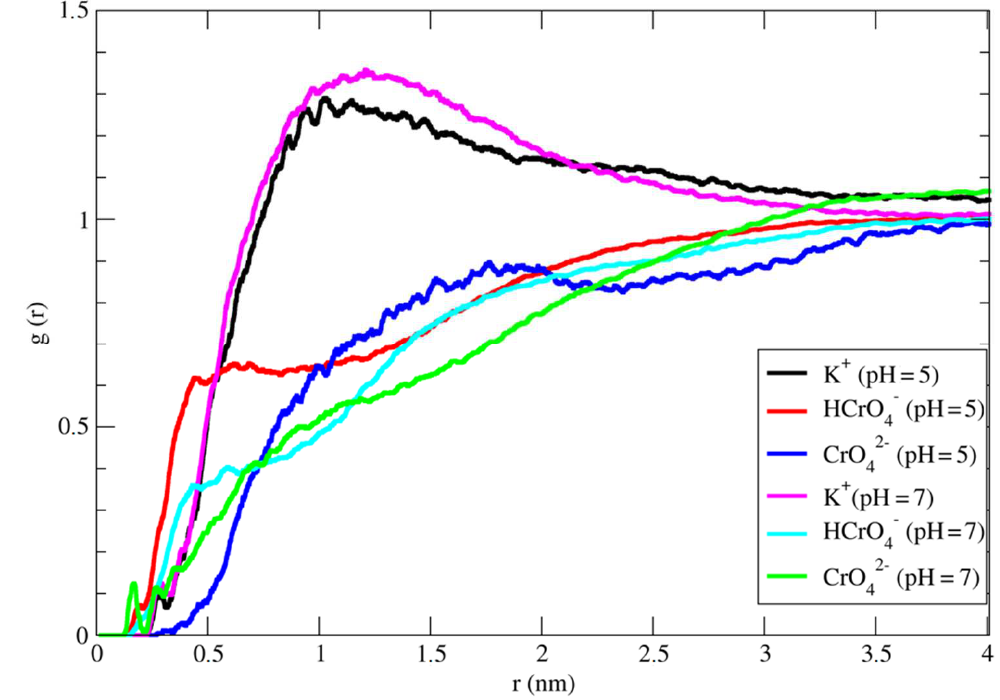
Figure 7. The radial distribution function of K + , HCrO 4− and CrO 42− ions around activated carbon molecule.